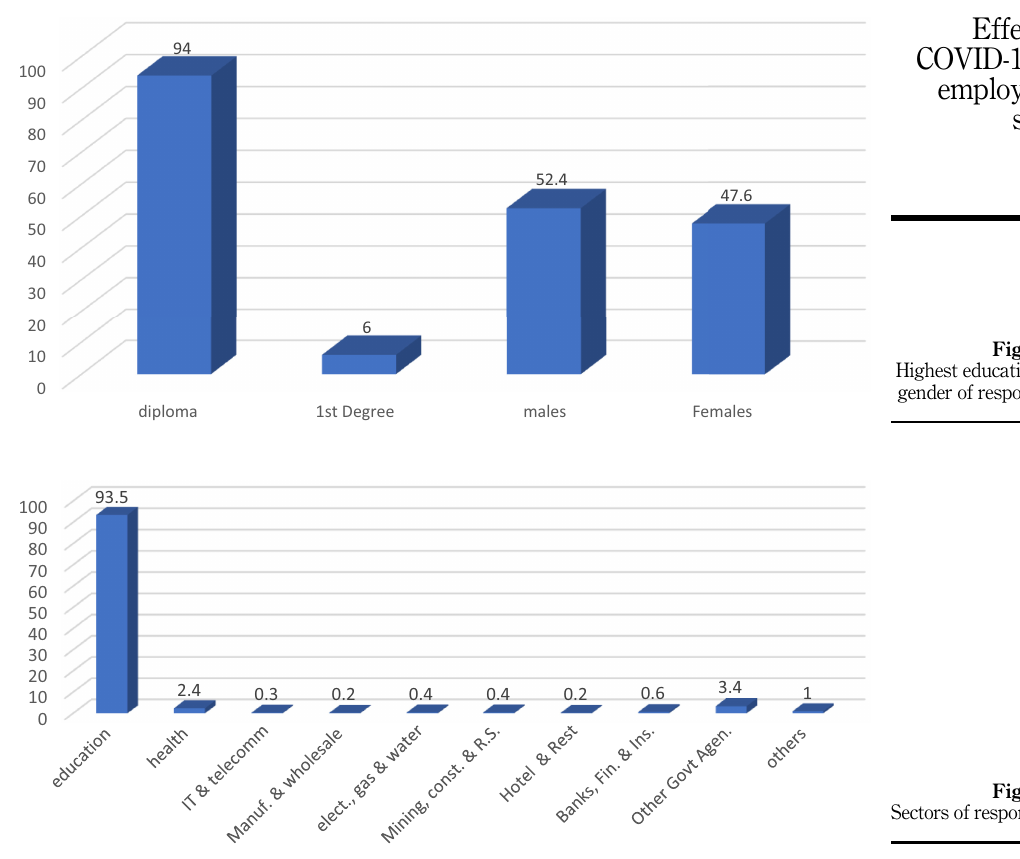
Figure 4. Sectors of